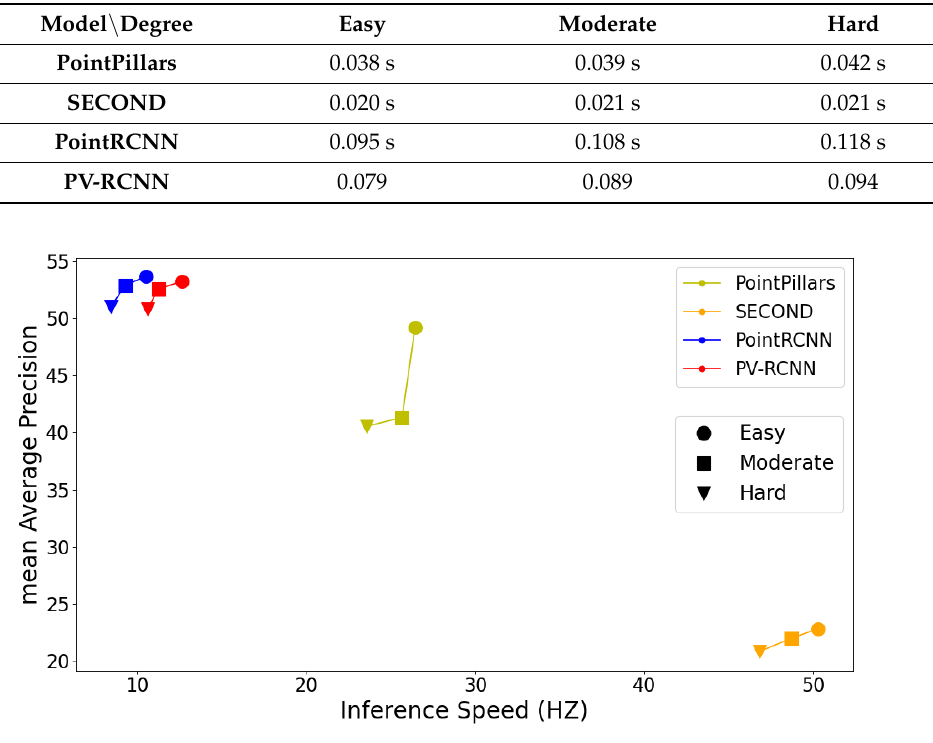
Figure 7. Model detection performance (mAP) versus speed (Hz) in KITTI dataset of our newly created class. created